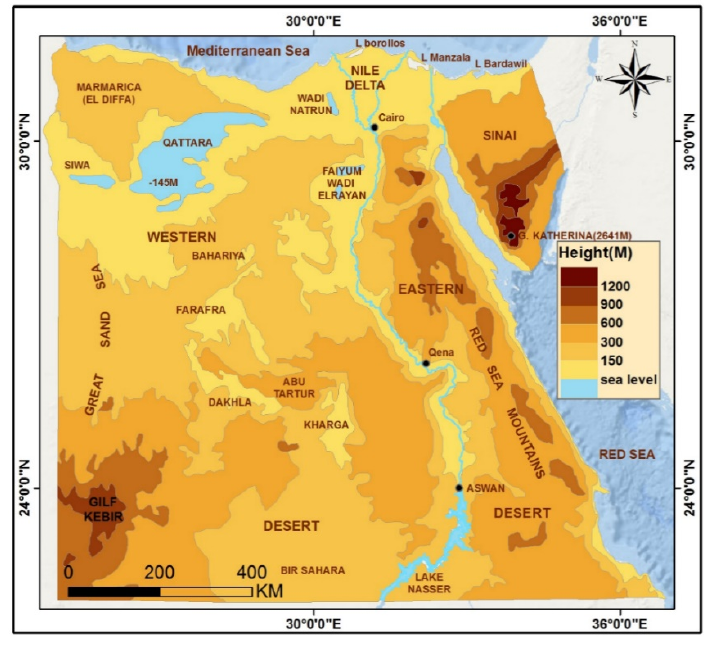
Figure 1. Relief map of Egypt.